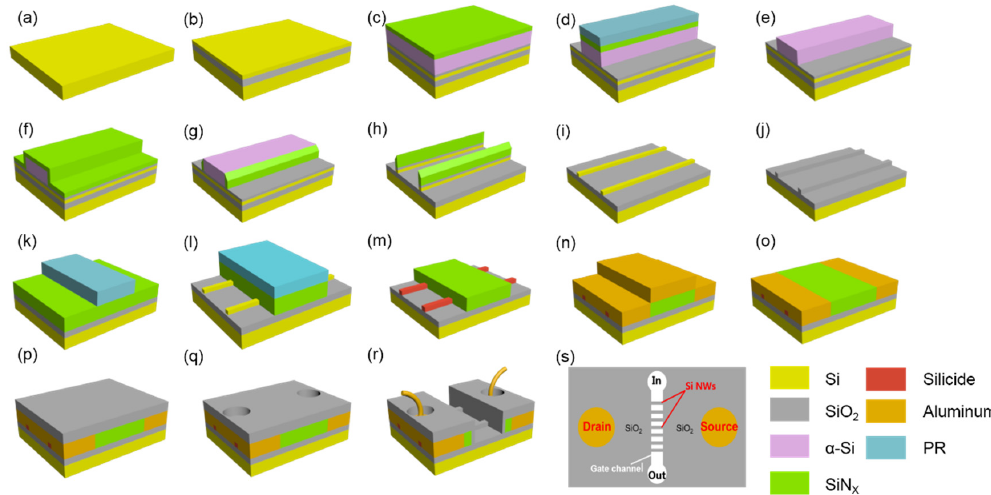
Figure 2. Fabrication flow of Si NW sensors. ( a ) 200 mm a p-type (100) silicon wafers, ( b ) deposition